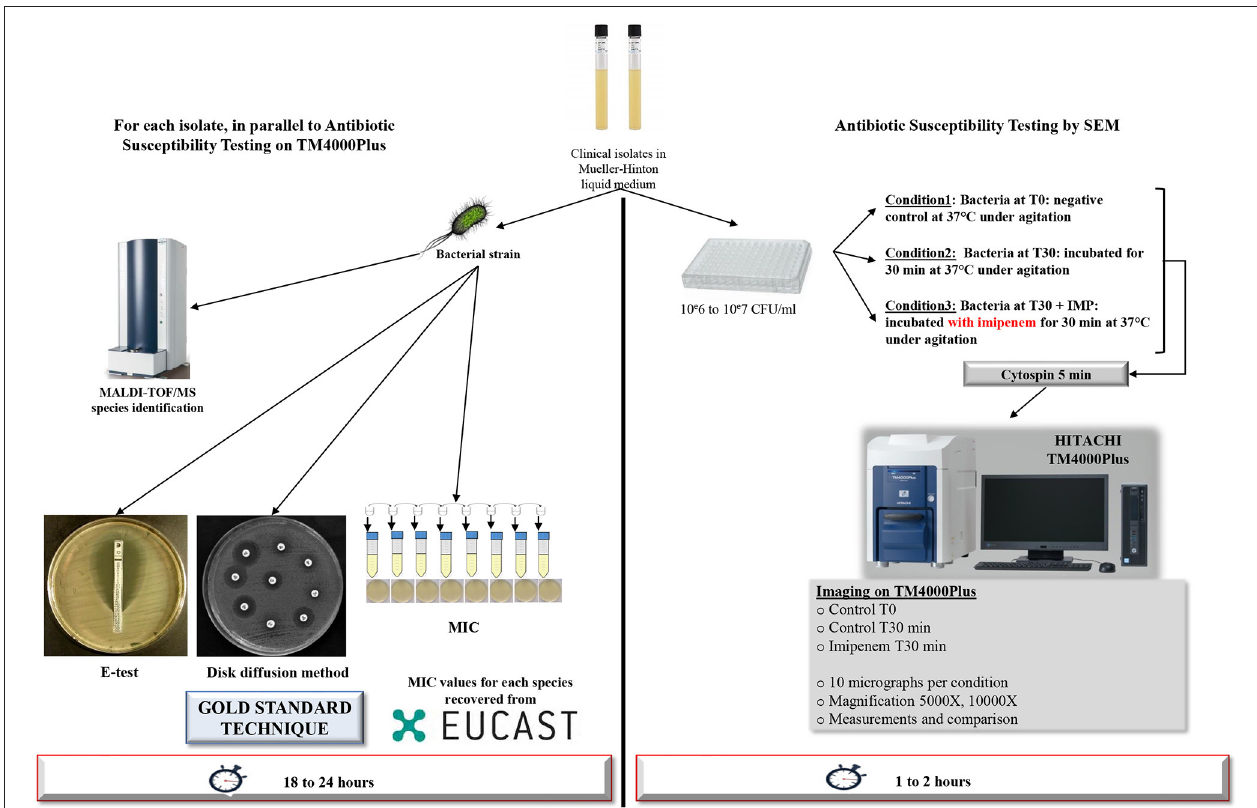
FIGURE 1 | Workflow of the strategy used. Detailed strategy applied to a selection of Gram-negative bacilli for resistance toward IPM tests after 30min of incubation using TM4000 Plus tabletop scanning electron microscope. For other time-points, the same strategy was applied.